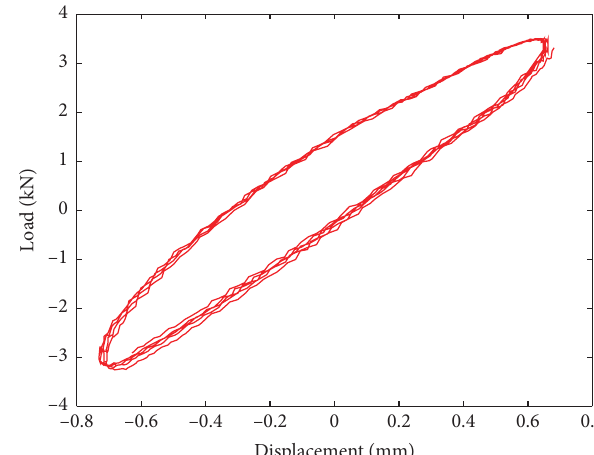
Figure 14: The excitation simulation hysteresis loop (for 4Hz and 0.7mm).